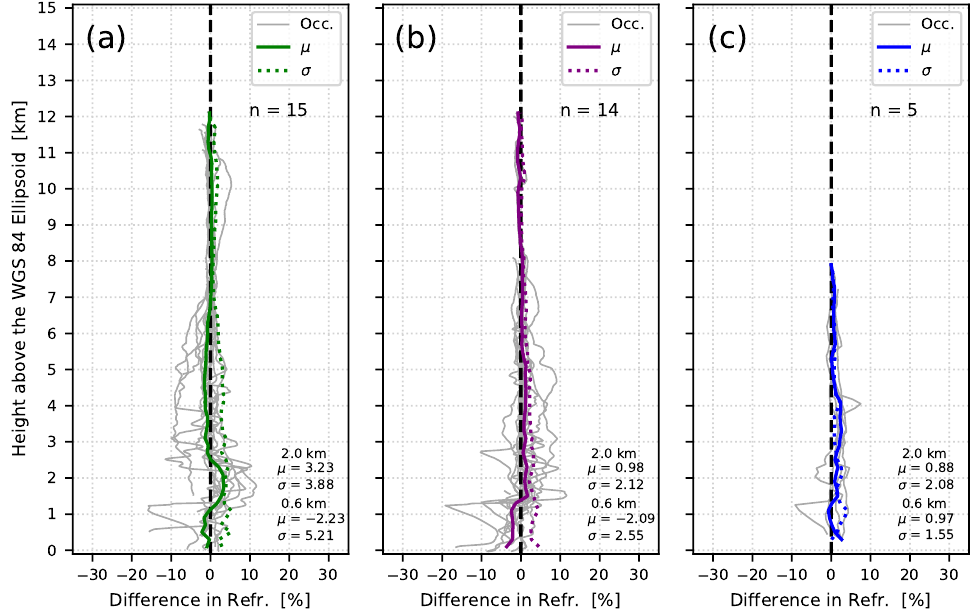
Figure 8. Same as Figure 7 but for occultation-dropsonde pairs that were outside an AR and were within a distance threshold of 300 km and a time threshold of 2 h. Labels are the same as Figure